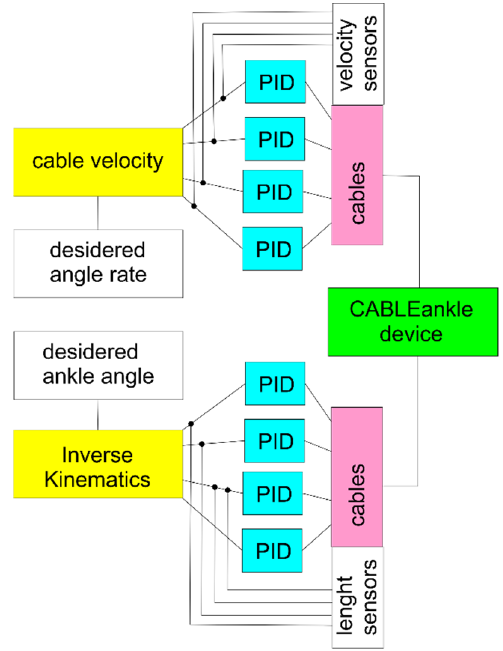
Figure 6. Flowchart of the designed control system for CABLEankle device.